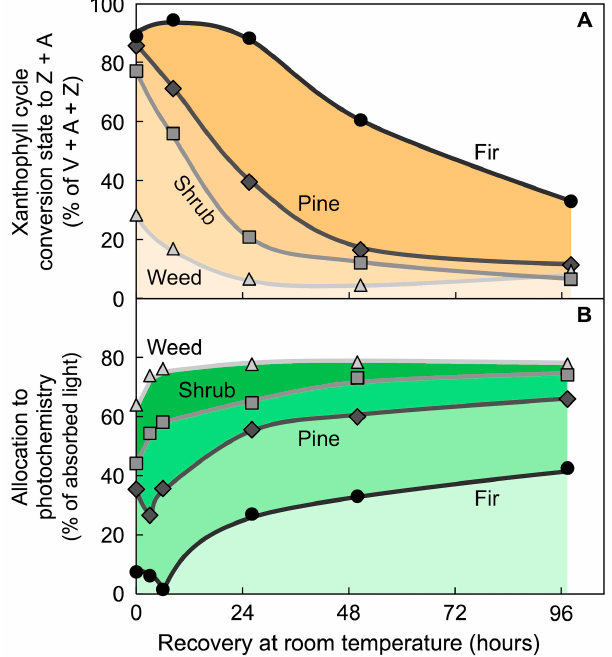
Figure 16. Changes in ( A ) percent of the xanthophyll cycle pool present as zeaxanthin and antheraxanthin (Z + A) and ( B ) percentage of absorbed photons allocated to photochemistry (quantified from chlorophyll fluorescence as photosystem II efficiency) in leaves of an herbaceous weed ( Malva neglecta , light gray triangles), a woody shrub ( Euonymus kiautschovicus , medium gray squares), and two conifers (ponderosa pine, dark gray diamonds, and Douglas fir, black circles) upon transfer from fully sun-exposed sites in mid-winter to continuous low light (10 µmol photons m − 2 s − 1 ) at room temperature. V = violaxanthin. Data are from Verhoeven et al. [93].